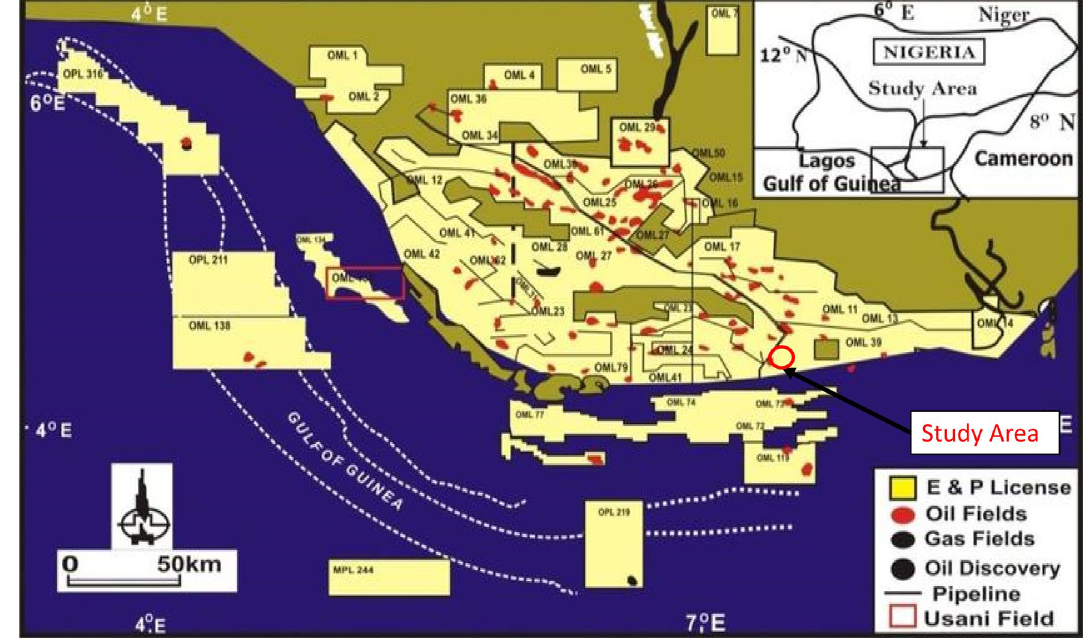
Fig. 1 Location map of the study area (Aigbadon et al.